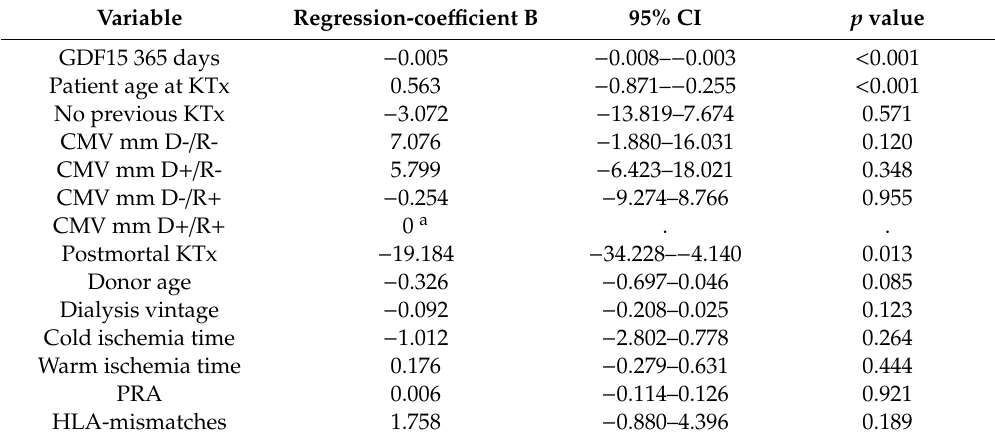
Table 4. Multivariable linear regression model for eGFR one year after KTx.